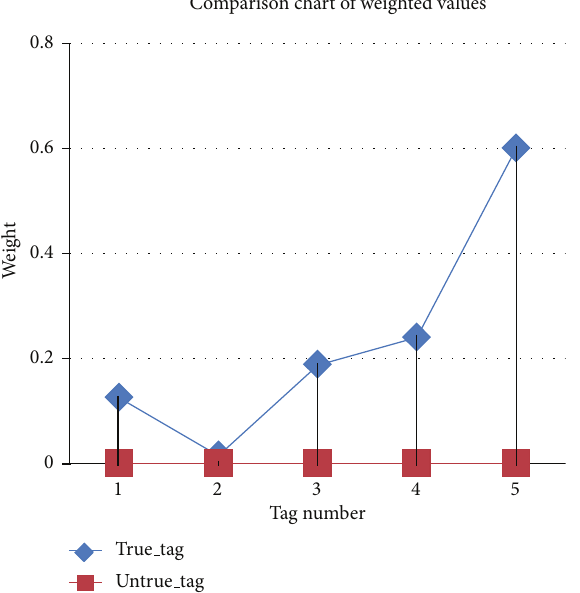
Figure 12: Comparison chart between “correct tagging” and “100% incorrect